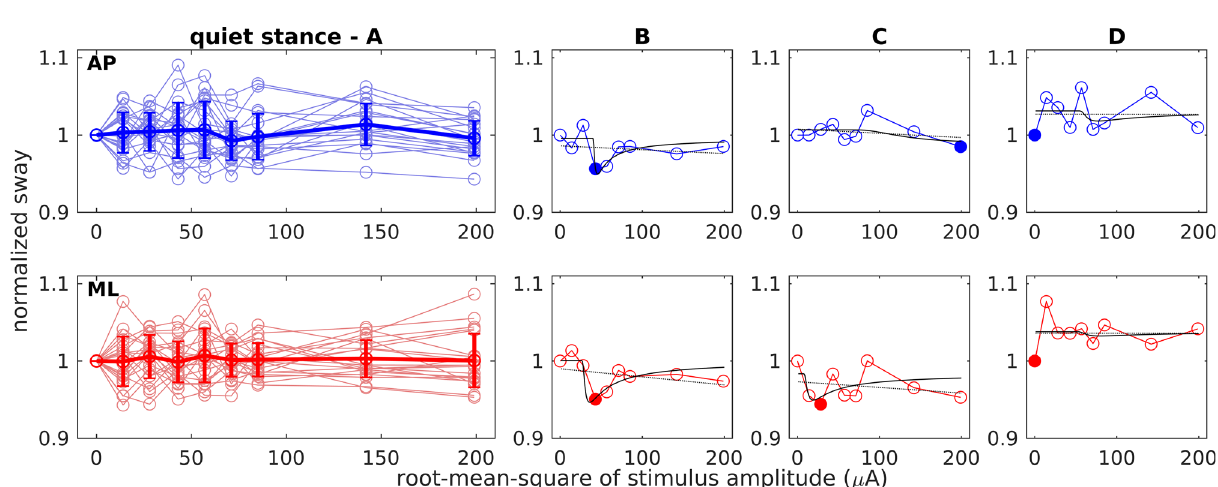
Figure 3. Normalized body sway path during quiet stance at varying nGVS intensities. Top row (AP, blue) shows anterior–posterior sway. Bottom row (ML, red) shows medio-lateral sway. ( A ) Responses of all subjects (light circles and lines) with group mean and standard deviation (thick line). ( B–D ) Three exemplary individual responses including the linear (grey) and the SR curve fit (black). Filled circles indicate minimum values. ( B ) Performance curve showing a SR-like bell-shaped with optimal improvement at an intermediate nGVS intensity. ( C ) Performance curve showing only optimal improvement at a particular nGVS intensity. ( D ) Performance curve showing none of the